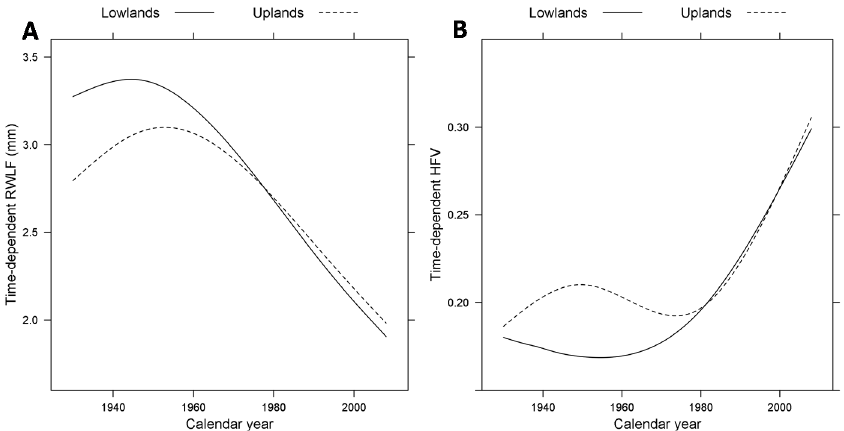
Figure 7. Long ‐ term and time ‐ dependent changes over time in ring ‐ width low frequency ( A ) and high ‐ frequency variability ( B ) for lowlands (full lines) and uplands (dashed lines). Both changes were more pronounced in lowlands than in uplands.